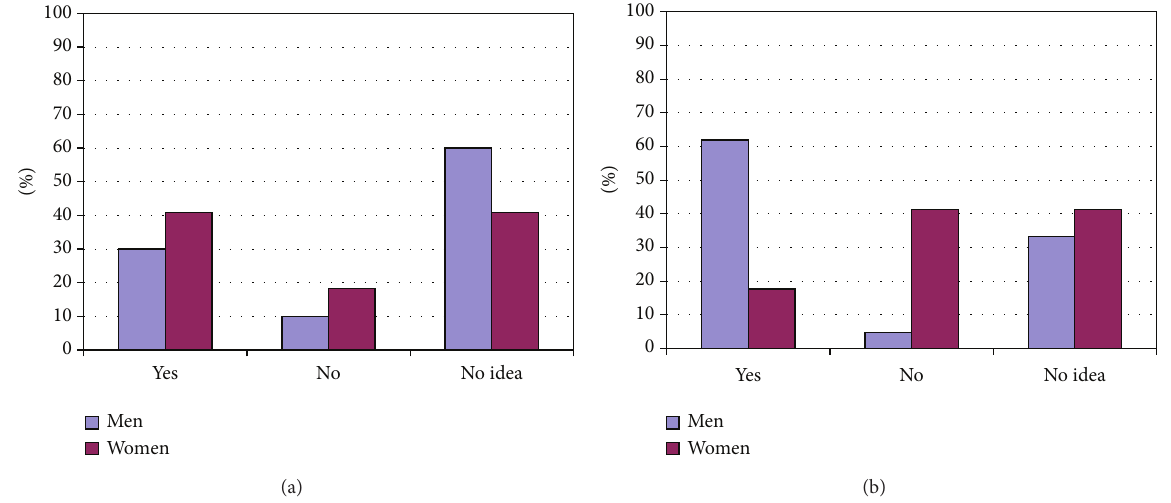
Figure 9: Usage of the geolocation feature within Instagram: DN (a) versus DI (b).